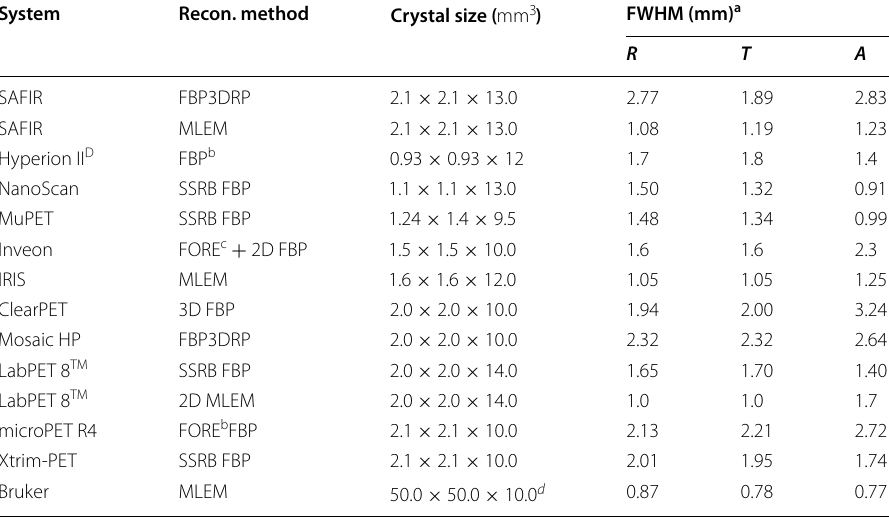
Table 2 Comparison of the spatial resolution of different preclinical PET scanners. Data are taken from